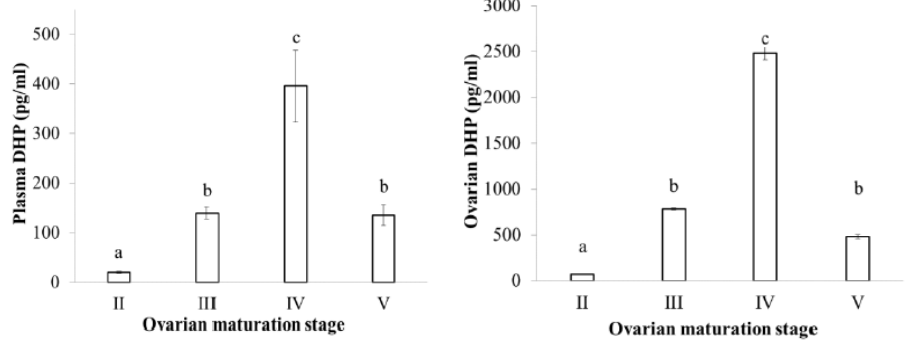
Figure 5. DHP level at different ovarian maturation stages of the blue tang fish (n the same as Figure 2b; data with a different subscript letter (a, b, etc.) are significantly different at p = 0.05).